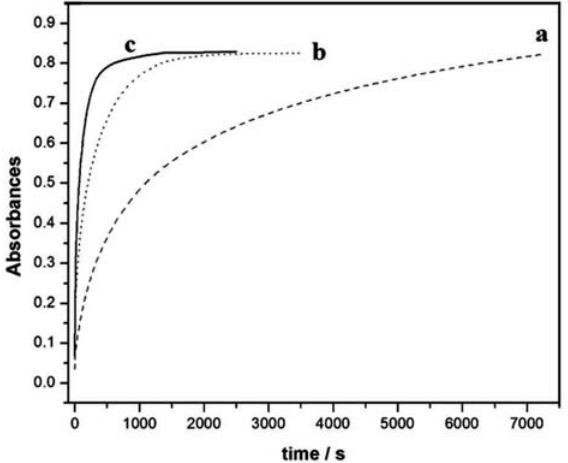
) , (6.50 × 10 –3 M) complex . 3 2